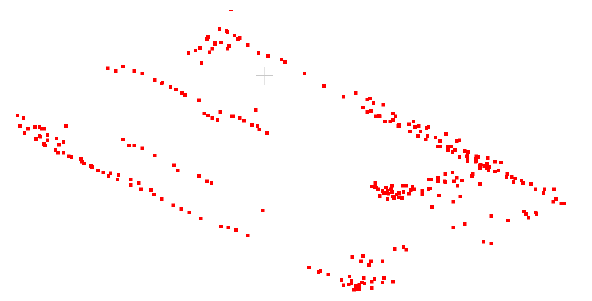
Figure 8: Top Edge Detection